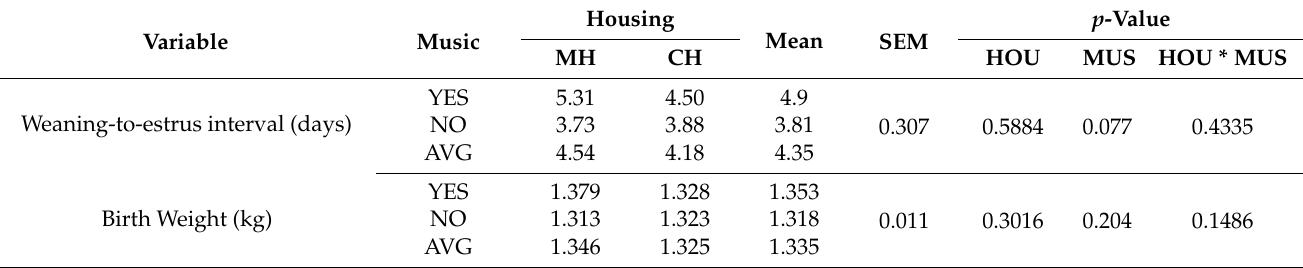
Table 4. Reproductive indices of sows from mixed (MH) or collective (CH) housing exposed or not to auditory environmental